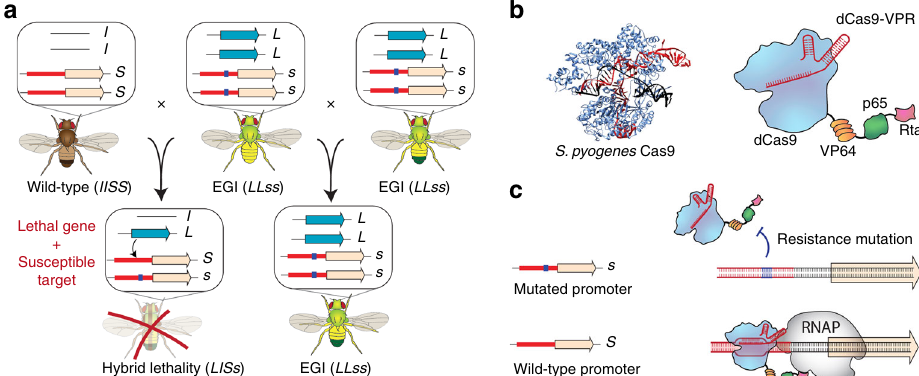
Fig. 1 Design of Engineered Genetic Incompatibility (EGI). a Schematic diagram of required genotypes for EGI. L , dominant lethal gene; l , wild-type allele (null); S , dominant susceptible allele; s , recessive resistant allele. b X-ray crystal structure of S. pyogenes Cas9 (PDB ID: 6o0z, left) and diagram of dominant lethal gene product, dCas9-VPR. c Interaction of dCas9-VPR with resistant (top) or susceptible (bottom) alleles. Blue square represents a mutation that abrogates dCas9 binding. RNAP, RNA